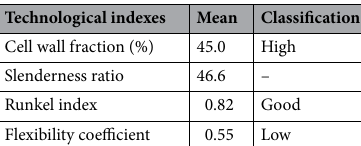
Table 3. Mean and classification of technological indexes available to Pterogyne nitens wood.